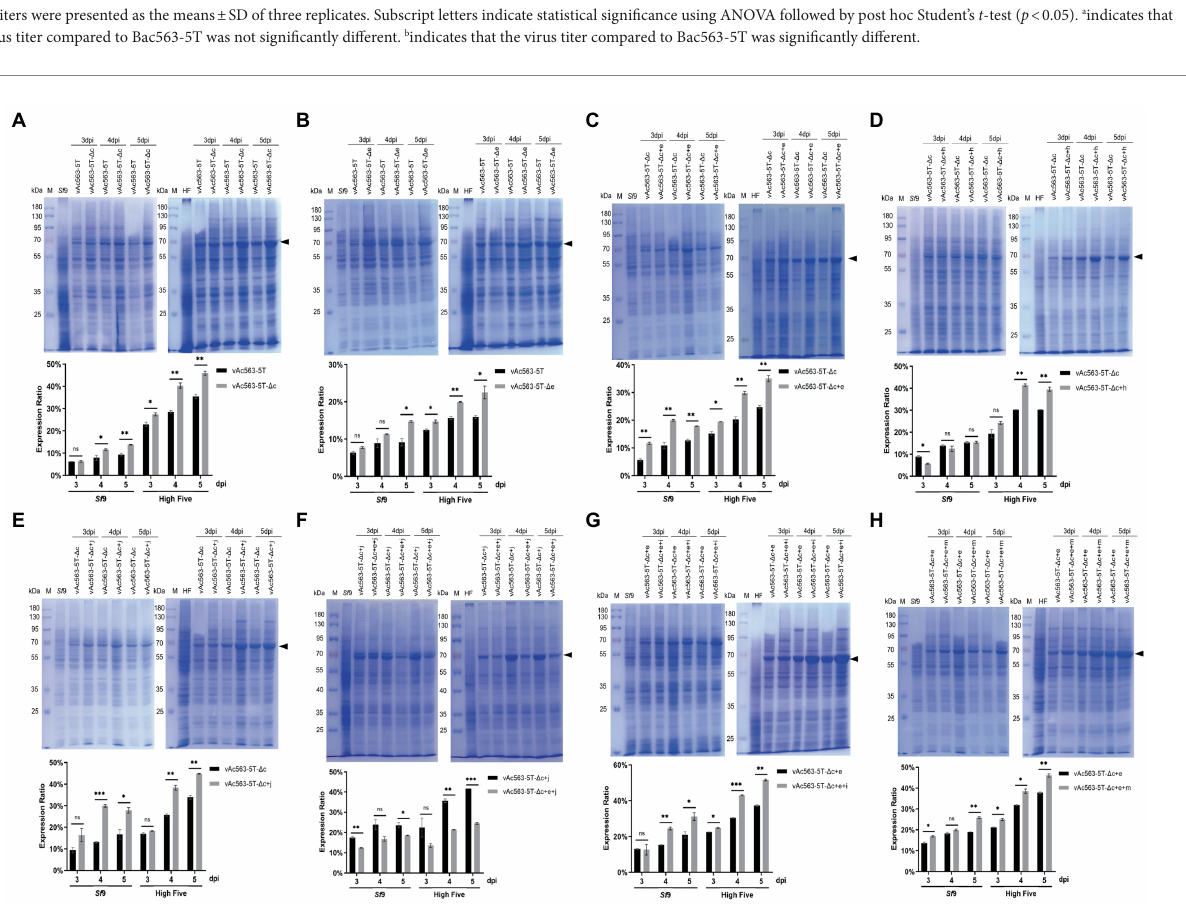
FIGURE 6 Expression of firefly luciferase (Fluc) using the indicated bacmid containing superimposed deletion of multiple nonessential fragments. (A-H) Impact of combination deletion of the indicated fragment on the Fluc expression. Cell lysates were harvested at 3, 4, and 5 dpi, separated by SDS-PAGE and visualized by coomassie brilliant blue R250 staining. The Fluc protein band is indicated by a black arrow. The protein bands were quantified by densitometry scanning using Image J software, and the expression levels of Fluc as a % of total cellular protein were calculated and the data were presented in the bar charts. * p < 0.05, ** p < 0.01, *** p <